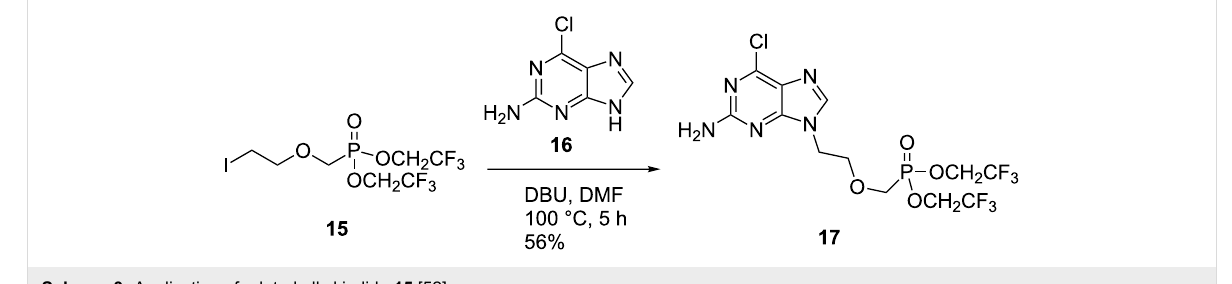
Scheme 3: Application of related alkyl iodide 15